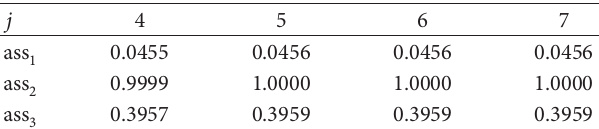
Table 1: Assumptions check for Example 1 with different values of 𝑗